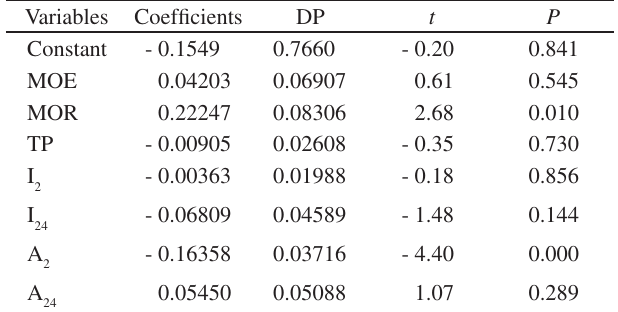
sum of squares (SQ), average squares (AS), F Test (F), and probability (p). The F test statistically proves the existence of the regression at a significance level of 5%, when F > F = 4.07, through Snedecor’s f υ 1, υ 2,5% distribution table or when p < 0.05. The degrees of freedom of the re- gression and the residual error are, respectively, υ 1 = 7 and υ 2 = 54. Table 3. Coefficients of regression of the independent variables DP . t . p . s . R 2 and n